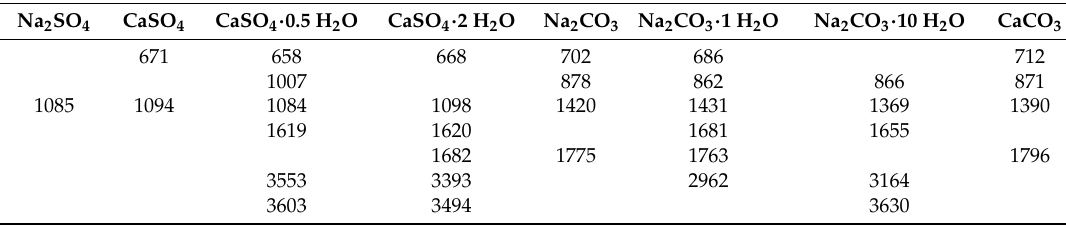
Table 1. Characteristic peak positions in the Fourier-transform infrared (FTIR) spectra of the reference materials in cm − 1